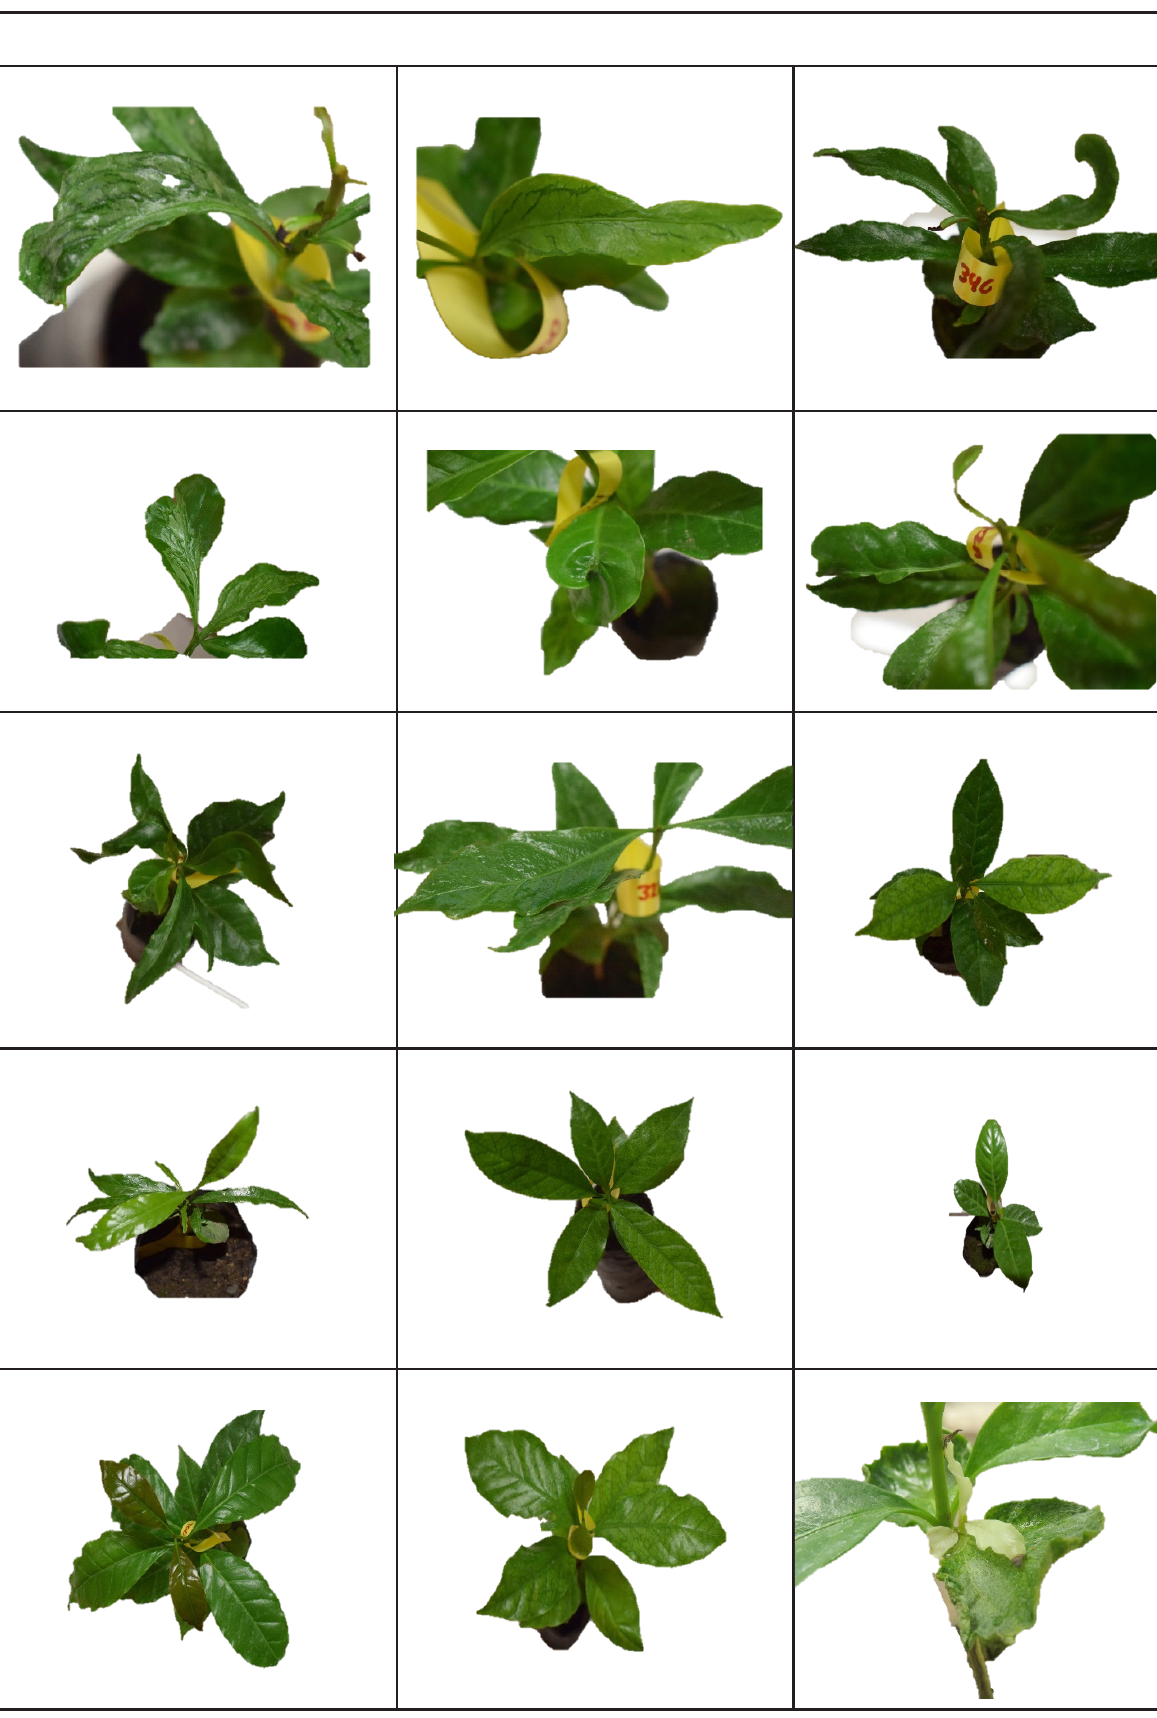
Figure 9. Morphological modifications in the leaves of the M1 generation of coffee( Coffea arabica L. var. typica) plants grown under nursery conditions on “Genova Farm,” San Ramon District, Department of Junín,